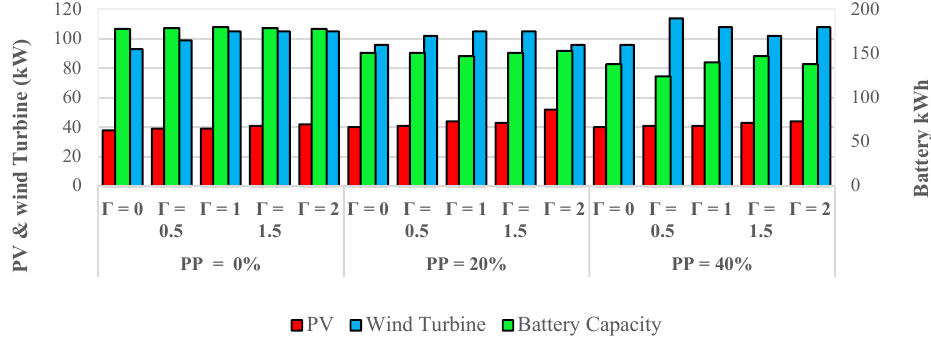
Figure 7. The calculated capacity of microgrid components with a 10% uncertainty set bound.